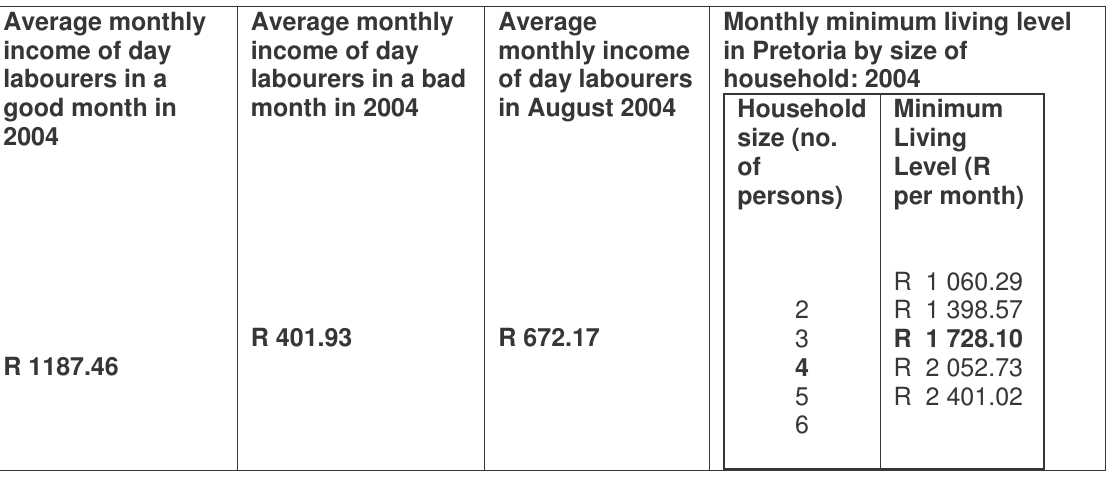
Table 1: Average monthly income of day labourers compared with the minimum living level of monthly income in Pretoria in